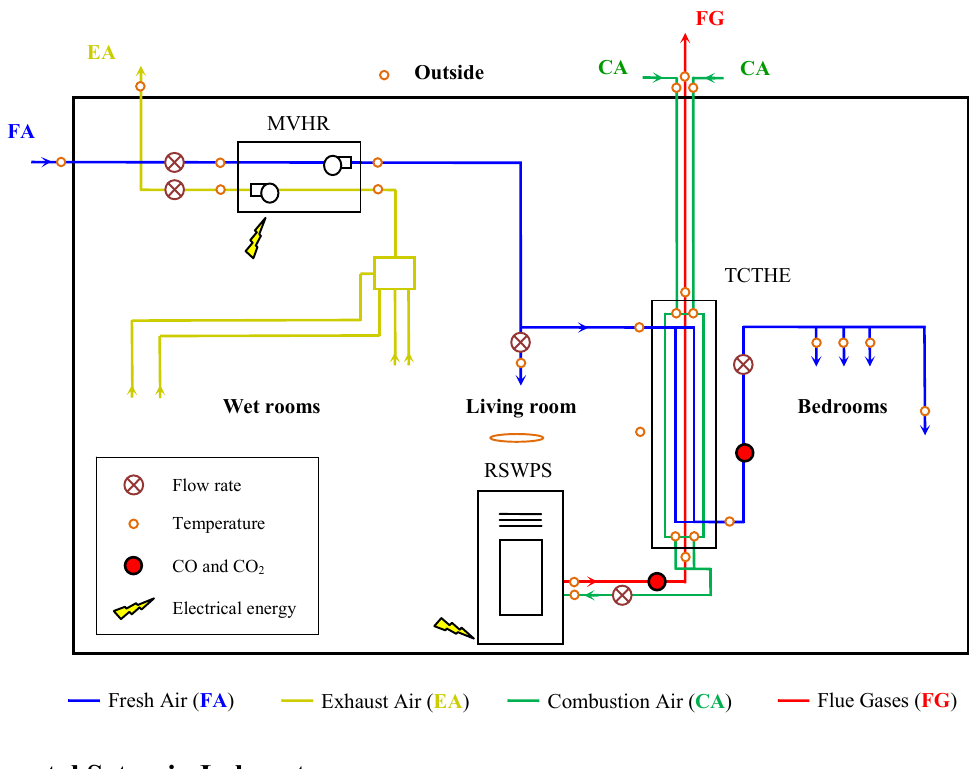
Figure 4. Scheme of the system configuration and implementation of